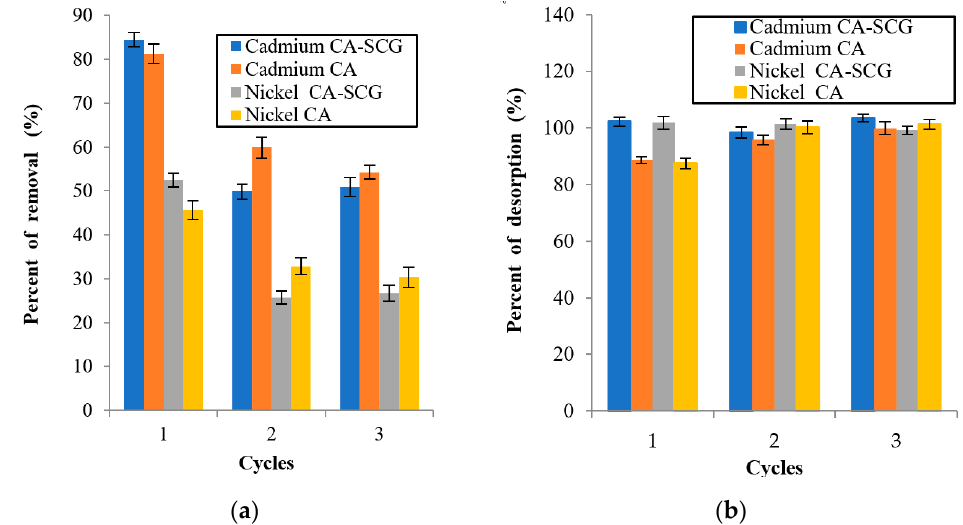
Figure 16. Adsorption/Desorption results for each cycle: ( a ) percent of removal of metal from the solution for each cycle and ( b ) percent of desorption of the metal from the bead for each cycle.